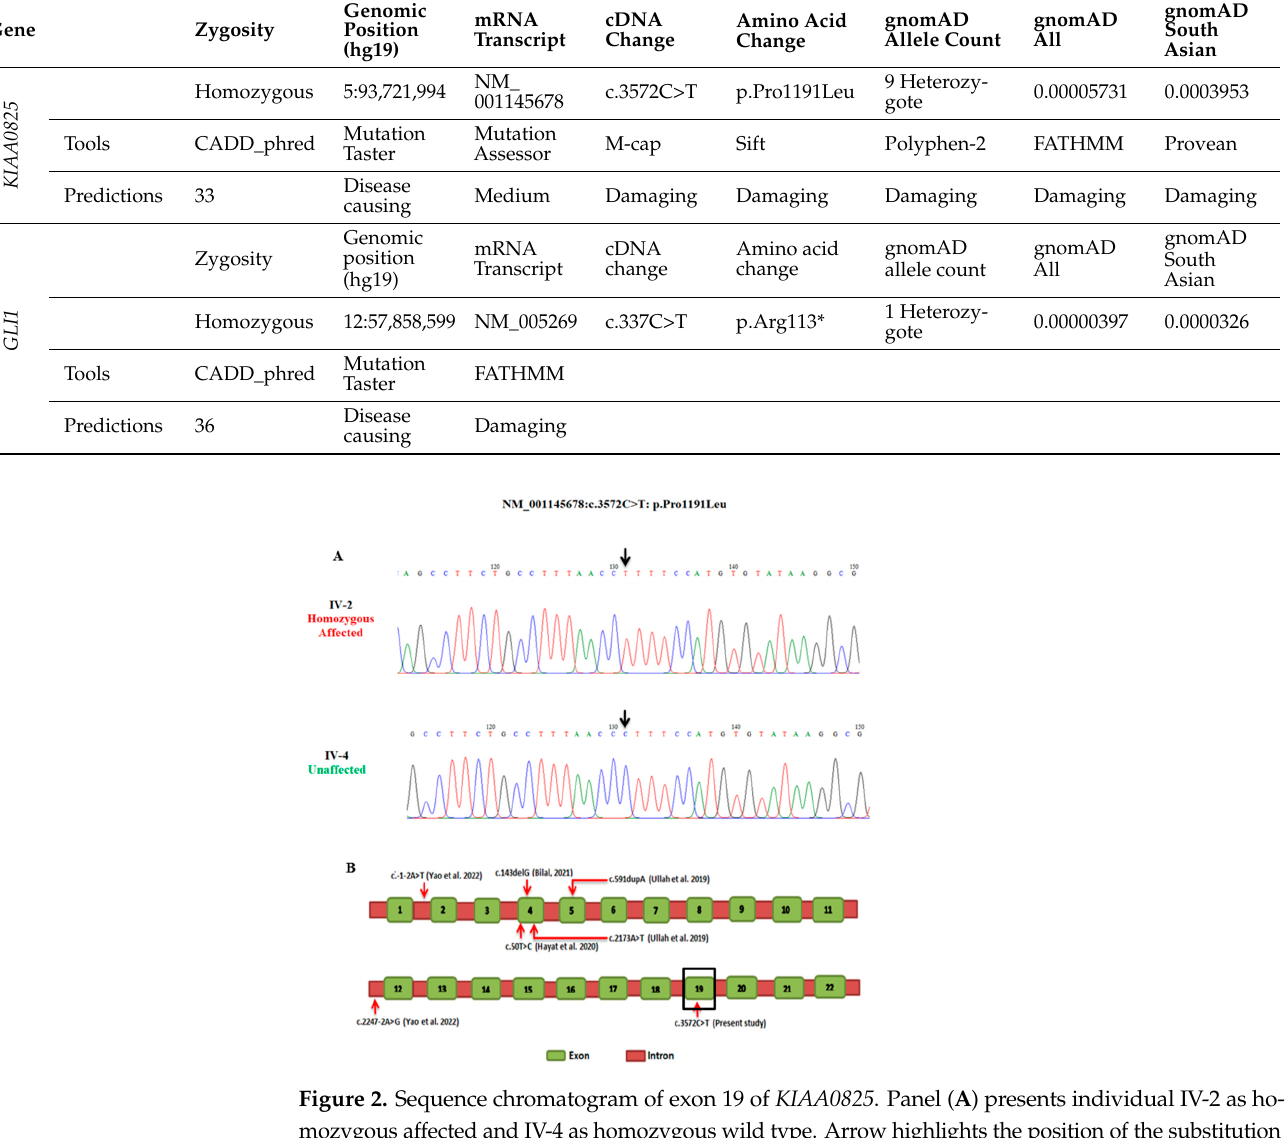
Table 2. Detail of the variants and in silico pathogenicity predictions.